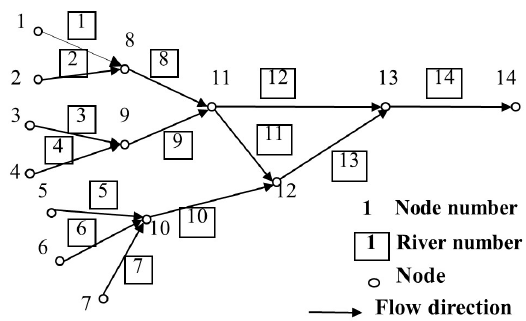
Figure 2. Illustration of the simulated water river network.